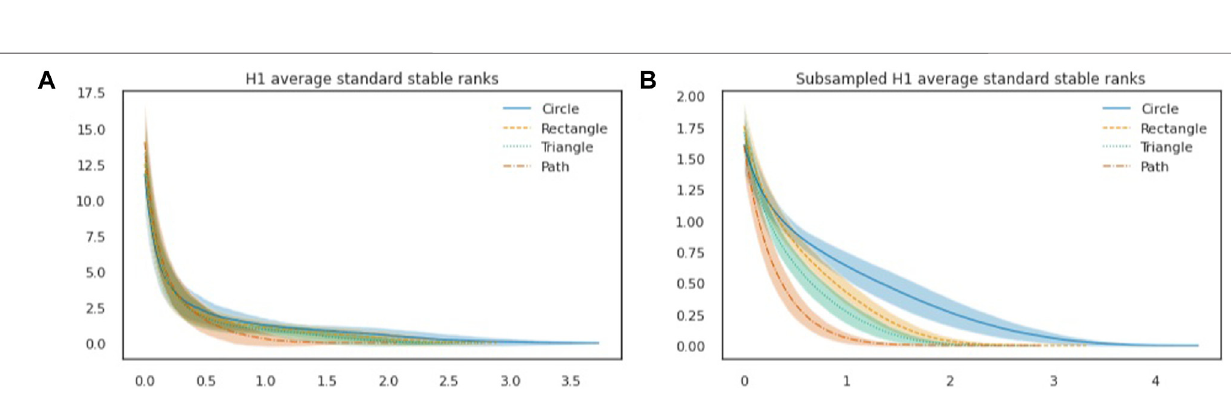
FIGURE 7 | First row: examples of point clouds representing four plane fi gures in the dataset, one for each of the four shapes, with 30% ambient noise. Second row: the corresponding standard stable ranks of the persistence modules given by the 1-st homology of the Vietoris-Rips complexes of the plane fi gures.